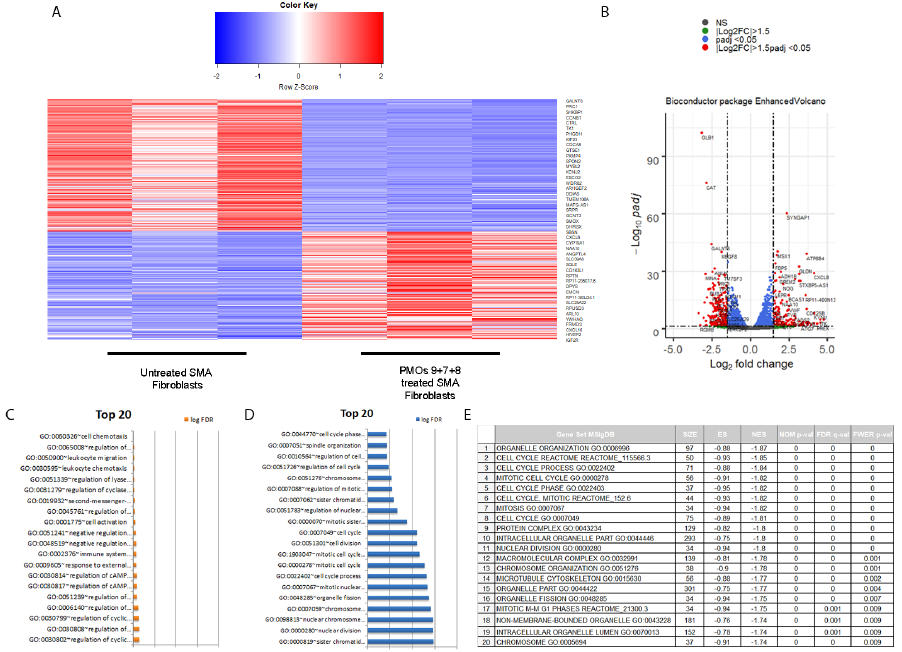
Figure 6. Differential expression comparing between PMOs9 + 7 + 8 treated SMA fibroblast and untreated SMA fibroblasts. Heatmap of the differentially expressed genes in three replicates of both conditions. ( A ) Volcano plot of differentially expressed gene list comparing between cells transfected with PMOs9 + 8 + 7 and untreated SMA fibroblasts. ( B ) Selected genes with absolute log2 fold change greater than 1.5 folds and p ‐ value lesser than 0.05 was analysed for its gene ontology. Top twenty of biological processes that were upregulated ( C ) or downregulated ( D ) in PMO treatment group compared to untreated control. Gene set enrichment analysis indicated that gene set regulat ‐ ing cell cycles were enriched at the normalised enrichment score (NES) of − 1.8477 and false discov ‐ ery rate (FDR) q ‐ value of 0.00 ( E ).